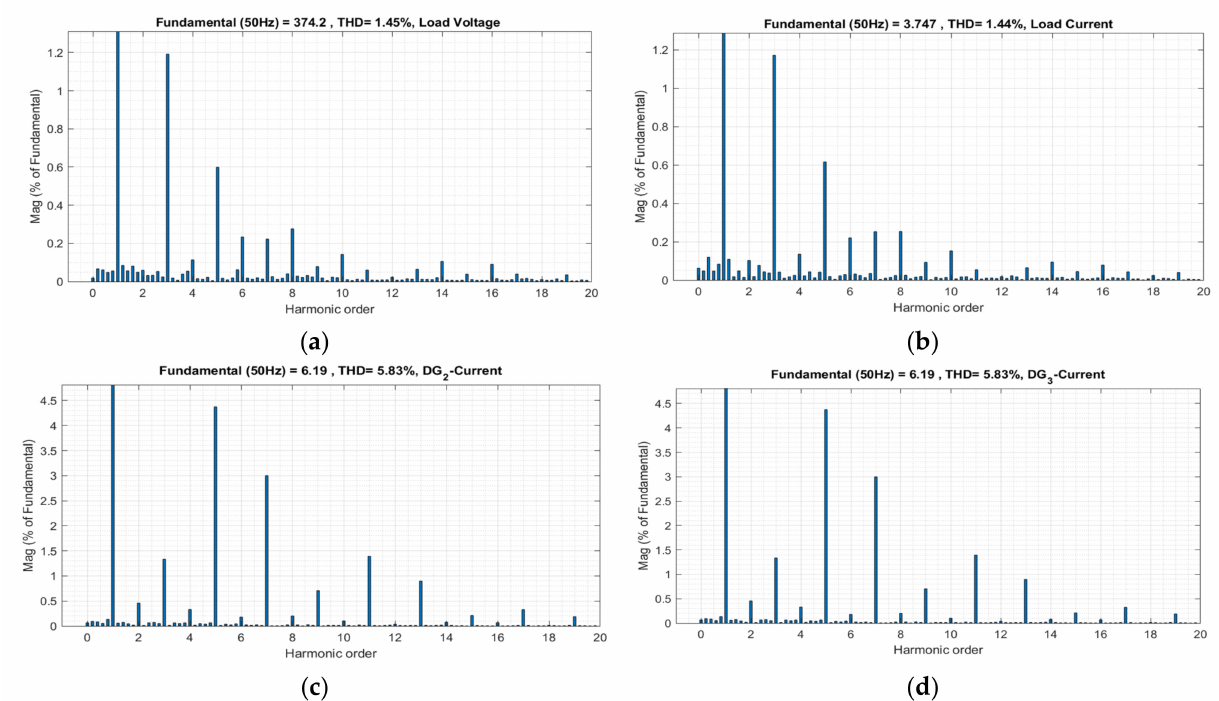
Figure 6. Load Voltage and Current THD Analyzing Under Asymmetric Inductive-Resistive Load: ( a ) the THD of the Load Voltage, ( b ) the THD of the Current Load, ( c ) the THD of the DG2, ( d ) the THD of the DG3.